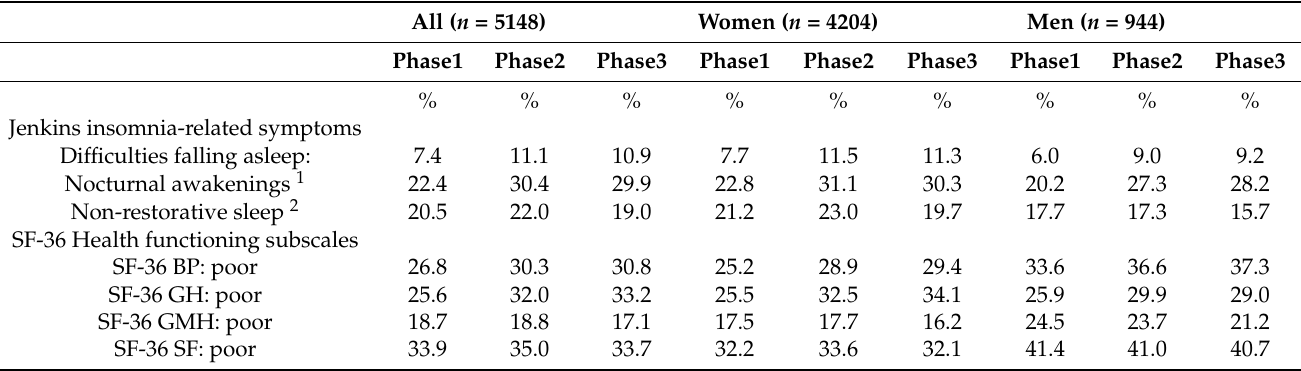
Table 2. Descriptive characteristics of sleep and health functioning in the study participants across study phases. Values are shown as percent of problems indicated by dichotomized indicator variables for repeated measures latent class analyses (RMLCA)